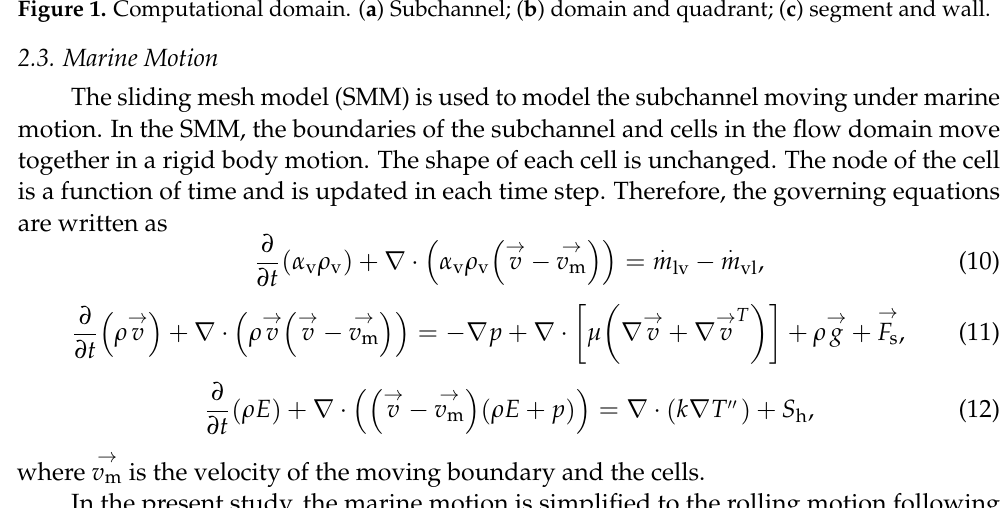
Figure 1. Computational domain. ( a ) Subchannel; ( b ) domain and quadrant; ( c ) segment and wall.